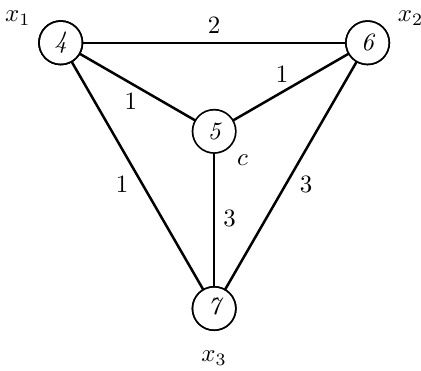
Figure 1. An irregular 3-labeling of the wheel W 3